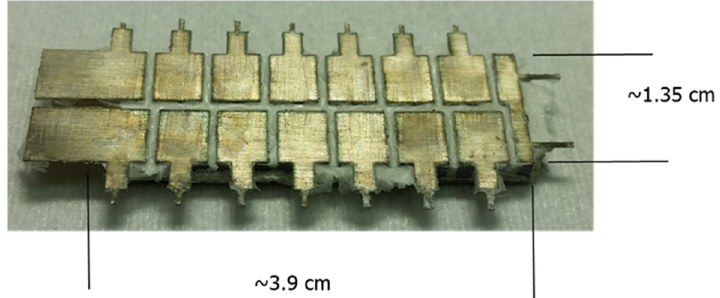
Figure 14. High-performance SKD-based TE module demonstrating 10% TE conversion efficiency and the highest reported power density in 2018.